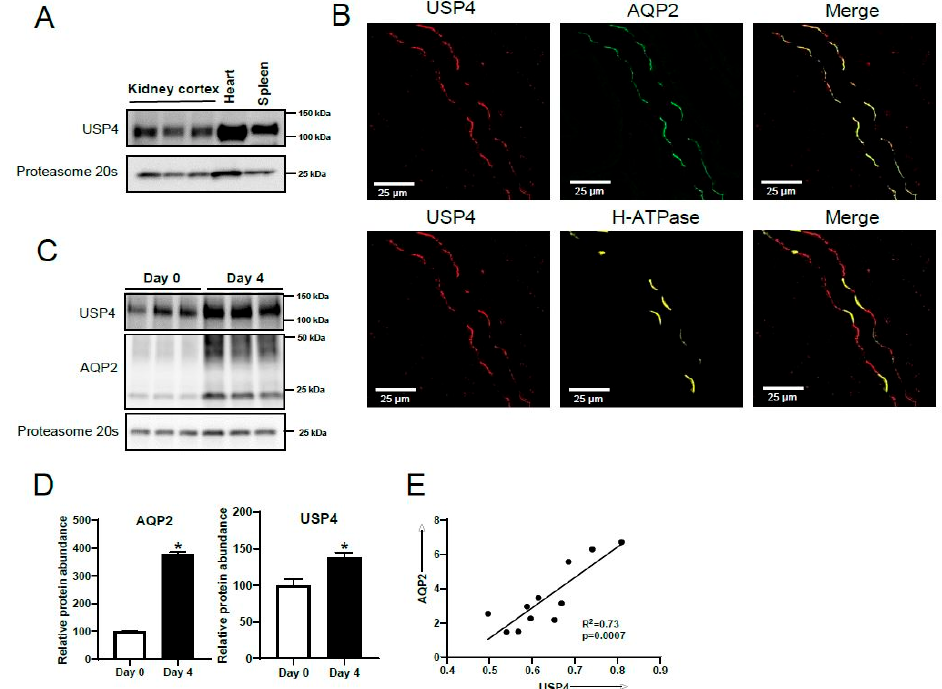
Figure 1. USP4 is expressed in the collecting duct in vivo and its abundance is regulated by vasopressin in vitro. ( A ) Immunoblotting using a USP4-specific antibody demonstrated USP4 to be abundantly expressed in mouse kidney cortex. Each lane represents a sample from an individual mouse, and heart and spleen tissues are positive controls. ( B ) Confocal microscopy images of mouse kidney sections immunolabeled with USP4, the principal cell marker AQP2, and the H+ATPase B1 subunit, an intercalated cell marker. AQP2 and USP4 co-localize at the apical plasma membrane of principal cells. ( C ) Representative immunoblot images of USP4 and AQP2 in mpkCCD14 cells cultured in dDAVP for 4 days. ( D ) Summarized data relative to day 0 (normalized to proteasome 20s). * indicates p < 0.05 relative to day 0. ( E ) Linear regression analysis of AQP2 and USP4 protein abundance in mpkCCD14 cells after dDAVP treatment for various periods (0, 24, 48, and 72 h).